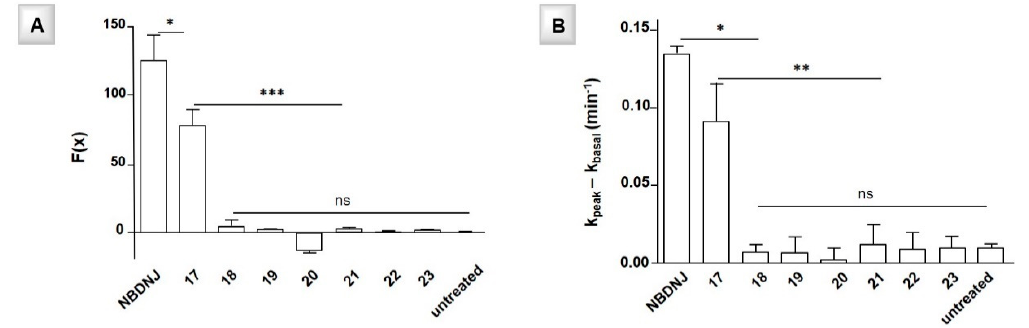
Figure 7. A ) Functional evaluation of F508del-CFTR by DiSBAC2(3) assay in CF-KM4 cells treated or